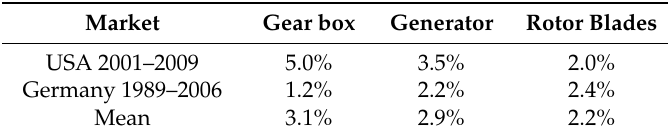
Table E2. Mean component replacement per year and wind turbine, based on empirical data from Germany and USA [53,54]. The means between these markets are also